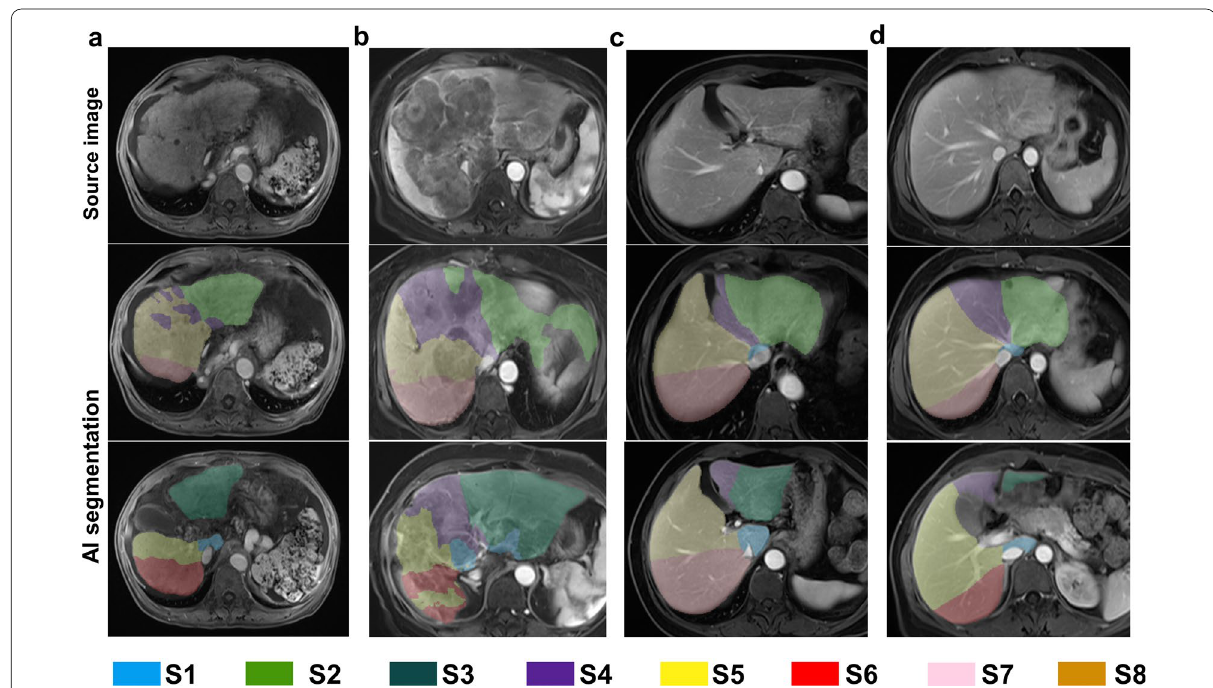
Fig. 5 Examples of erroneous segmentations from AI in the clinical evaluation set. a A case of liver cirrhosis. Obvious intersegment misidentification occurred in the liver right lobe. Morphological changes in the liver and poor visualization of the hepatic veins can be observed in the corresponding source image. b A case of liver metastases. Oversegmentation errors occurred in the whole liver. Intrahepatic vasculature was diffusely invaded by metastases. c A case of gallbladder in ectopic locations. The gallbladder lies in the hepatic longitudinal fissure instead of the gallbladder fossa. Most likely for this reason, S4 was assigned to the left lobe by AI segmentation. d A case with hepatic vein variation. AI might mistake the large right posterior hepatic marginal vein for the right hepatic vein, which causes a rightward shift of the border line between the right anterior lobe and right posterior lobe. AI, artificial intelligence; S,